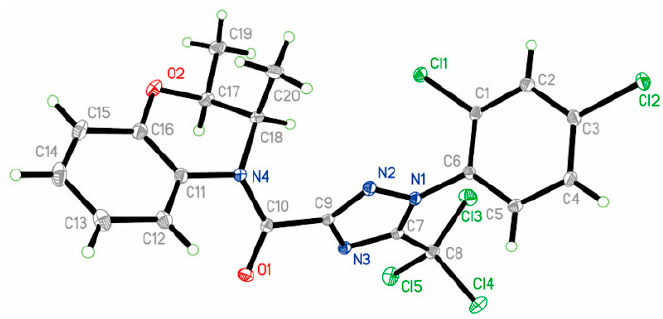
Figure1. Molecularstructureofcompound 5j . Thethermalellipsoidsareshownat30%probabilitylevel. Figure 1. Molecular structure of compound 5j . The thermal ellipsoids are shown at 30% probability level.